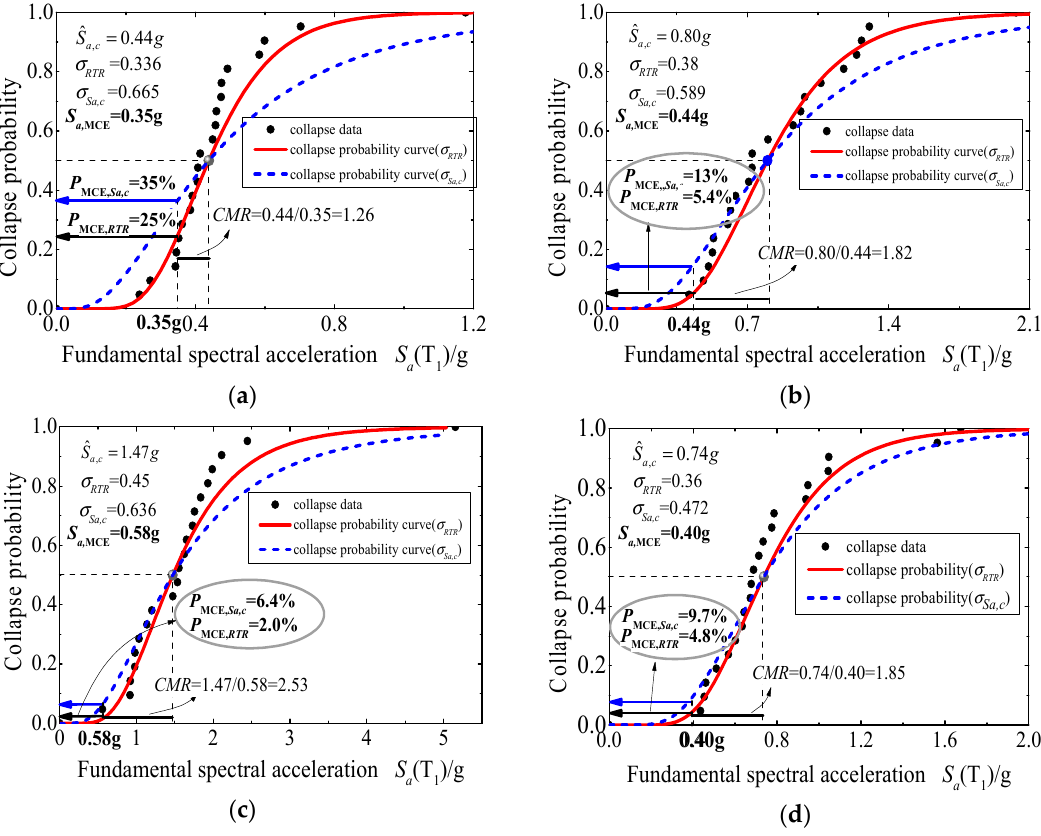
Figure 8. Collapse probability curves of ( a ) NS-1, ( b ) RS-1, ( c ) RS-2, and ( d ) S-1.